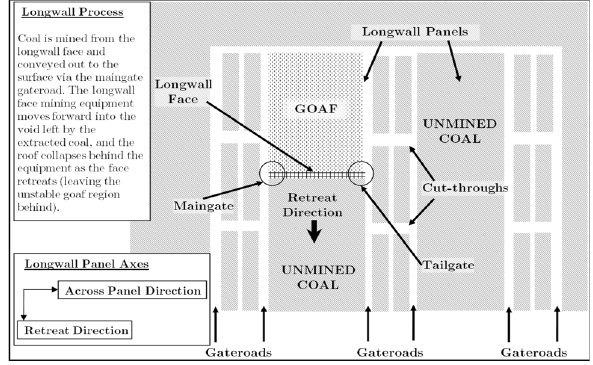
Fig. 1 Plan view of a longwall coal mine Fig. 2 Detail view of longwall face showing creep and